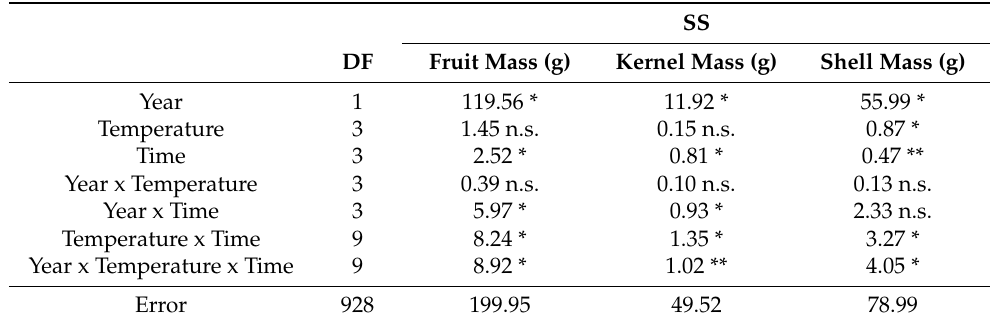
Table 7. Results of the combined univariate analysis of the change in mass of hazelnut samples with respect to the parameters year, temperature, and duration of the process.